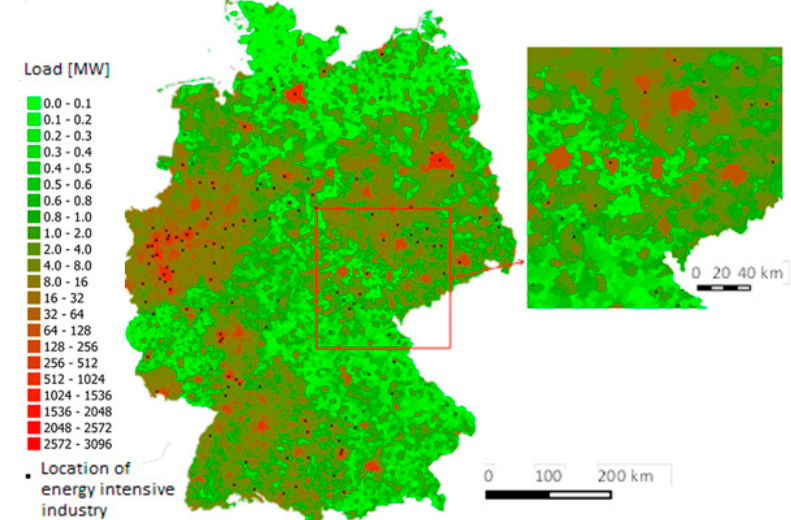
Figure 6. Electrical load on 5 December 2013 at 18:00 with adjusted load factors and displaying the location of energy-intensive industries [58].